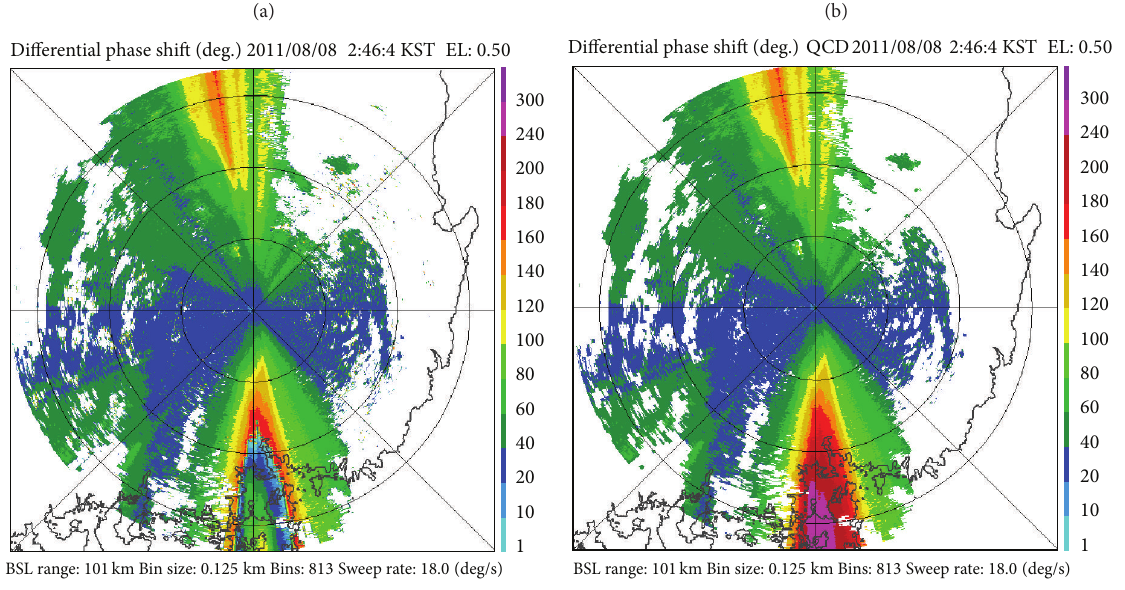
Figure 6: The results of noise removal and unfolding of differential phase shift. (a) Raw Φ noise removal and (b) after noise removal. (c) Raw Φ